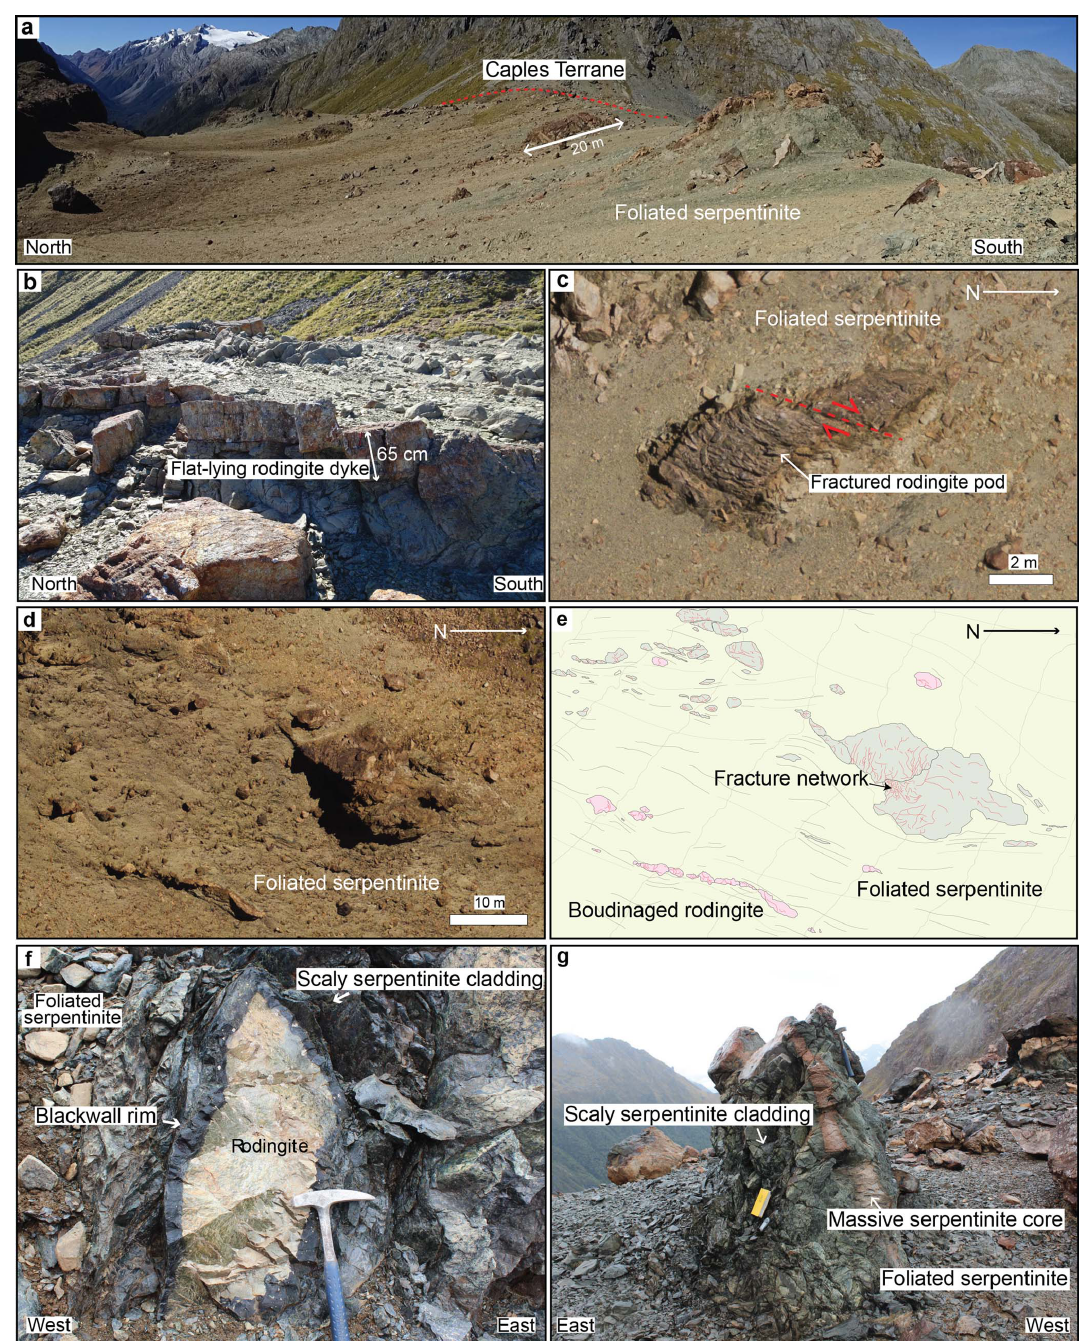
Figure 8. Shear zone structures at Serpentine Saddle. Location of the images shown on the map in Fig. 7. (a) Panorama of Serpentine Saddle looking east towards the Caples–Aspiring Terrane wall rocks. Upstanding spines on the ridgeline are elongate pods of massive serpentinite and rodingite. (b) Gently dipping rodingite dykes in a large massive serpentinite domain. (c) High-resolution orthophoto showing an intensely fractured and boudinaged rodingite pod surrounded by scaly serpentinite. (d) High-resolution orthophoto and (e) corresponding line tracing showing a boudinaged rodingite dyke (bottom left in both figures) and two large pods of massive serpentinite that have been brought into contact. A dense network of fractures radiates outwards from the contact region between the two pods of serpentinite. (f) Rodingite pod enclosed by a blackwall rim and surrounding matrix of scaly serpentinite. (g) Serpentinite pod with a massive serpentinite core and a cladding that transitions to scaly